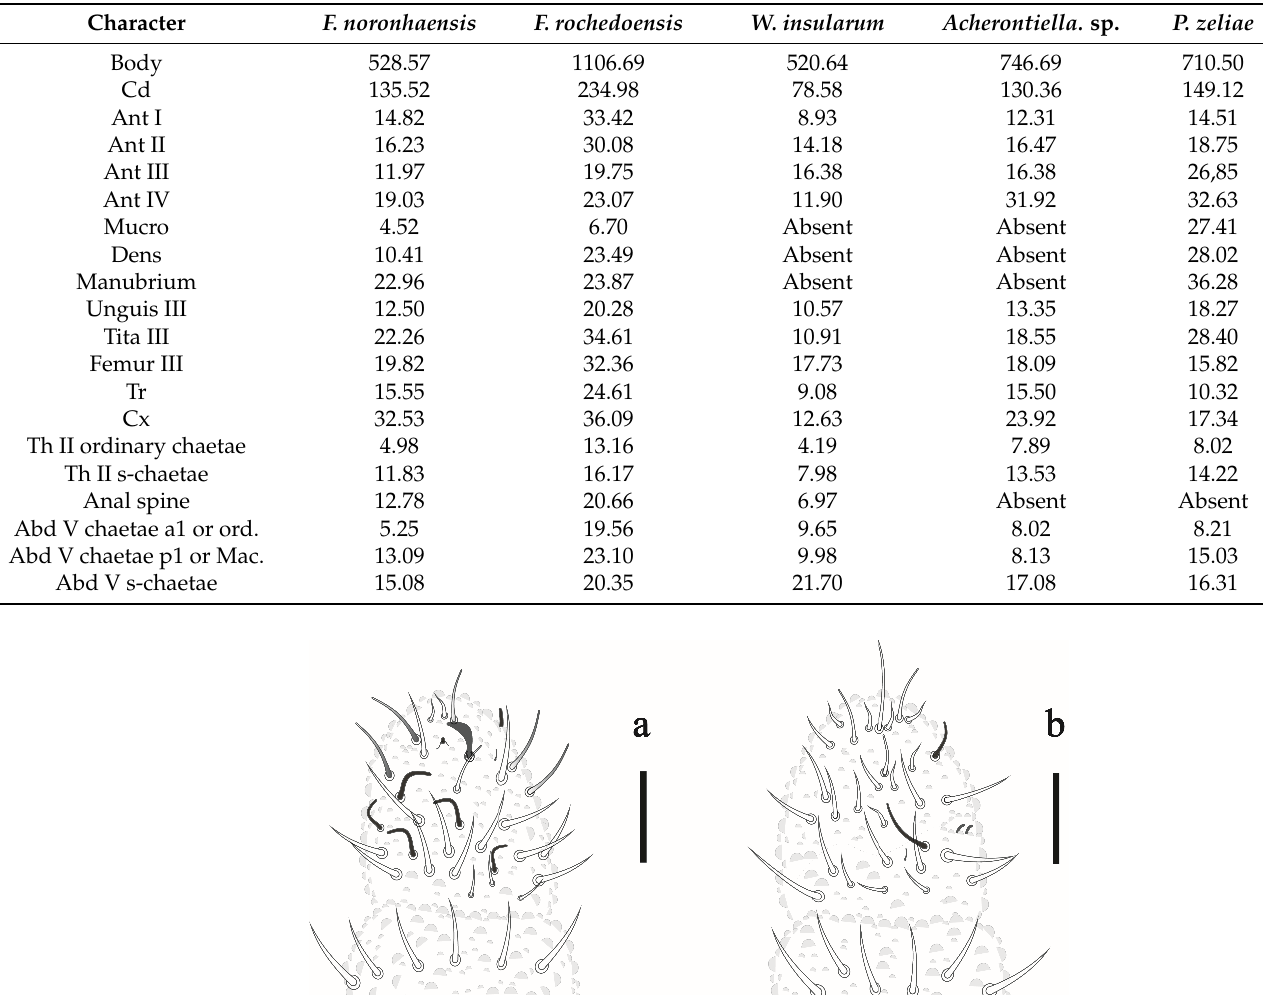
Table 2. Holotype measurements for Friesea noronhaensis sp. nov., Friesea rochedoensis sp. nov., Willemia insularum sp. nov.,